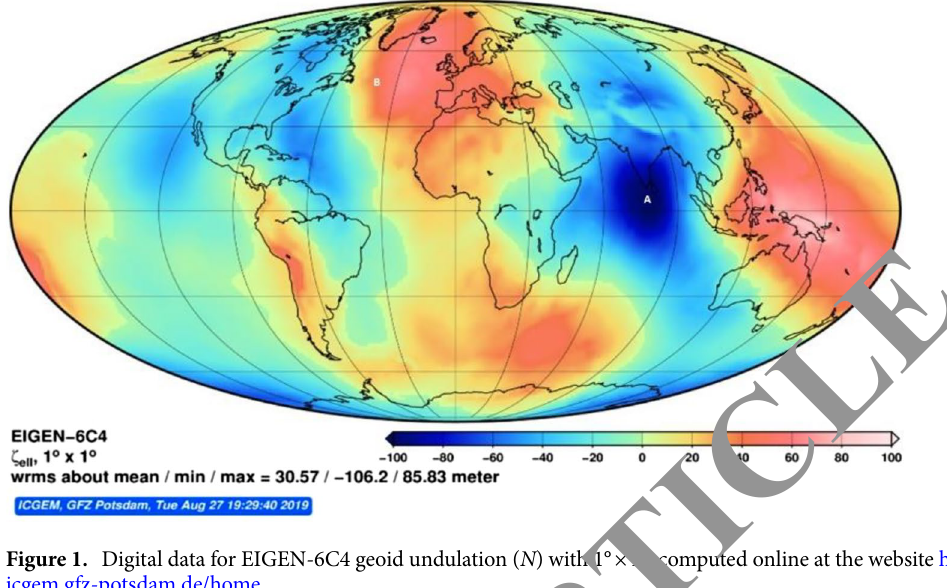
Figure 1. Digital data for EIGEN-6C4 geoid undulation ( N ) with 1° × 1°, computed online at the website http:// icgem. gfz- potsd am. de/